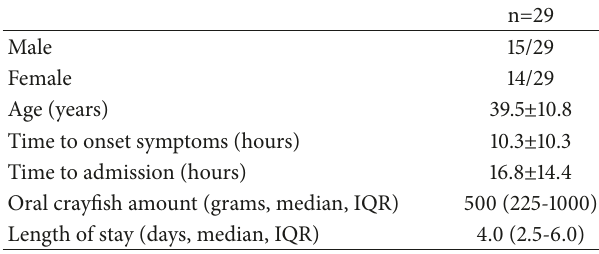
Table 1: Baseline demographics of twenty-nine cases of rhabdomy- olysis.